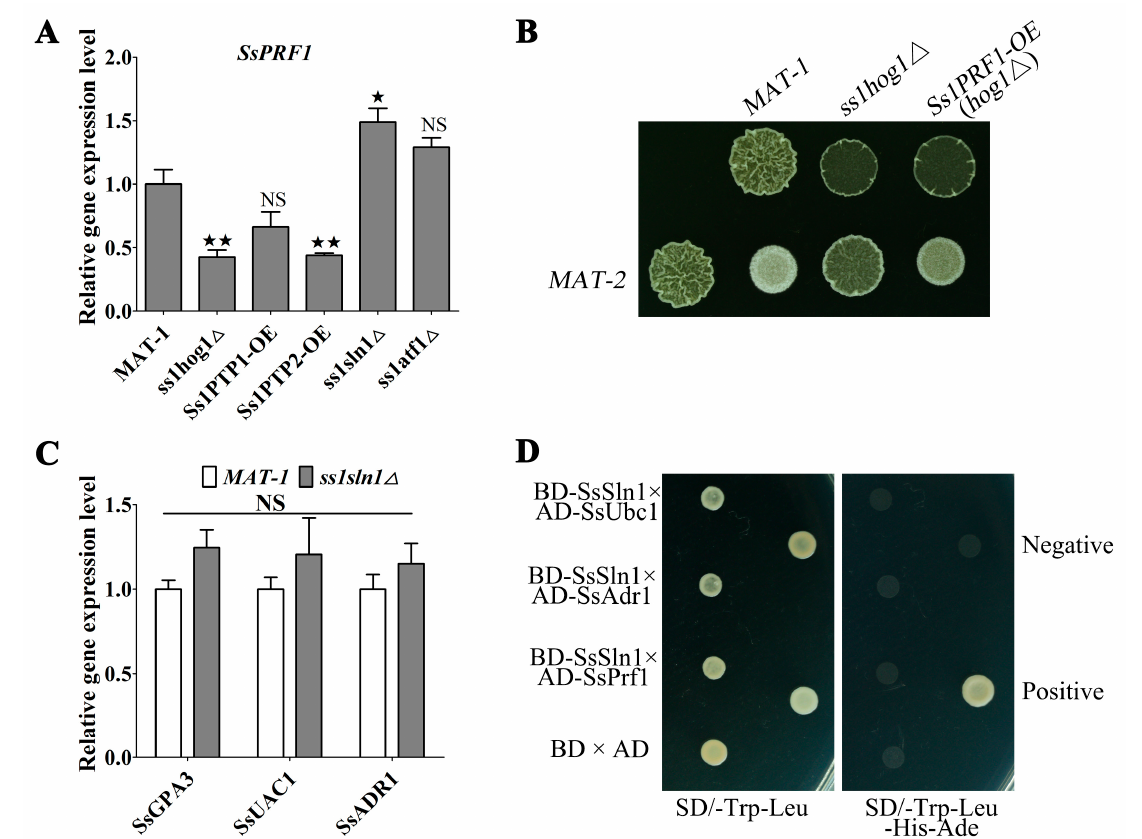
Figure 6. The relationship between SsSln1 and cAMP/PKA pathway in regulating the transcription of SsPRF1 . ( A ) RT-qPCR analysis of SsPRF1 gene expression in the MAT-1 , ss1hog1 Δ , Ss1PTP1-OE , Ss1PTP2-OE , ss1sln1 Δ and ss1atf1 Δ strains under sporidial growth on YePSA plate for 30 h, respectively. The relative gene expression level was calculated by following the - ΔΔ Ct method with ACTIN as an internal control. Bar chart depicts the statistical difference among the mean values ( ★ p < 0.05, ★★ p < 0.01). Mean ± S.E. were derived from three independent biological repeats with three replications. ( B ) Mating assay of mutants. Sporidia from MAT-1 , ss1hog1 Δ and SsPRF1-OE ( hog1 Δ ) strains were separately mixed with an equal volume of MAT-2 sporidia and spotted to YePSA medium to incubate at 28 °C. Images were taken after 40 h of cultivation. ( C ) Transcriptional profile of SsGPA3 , SsUAC1 and SsADR1 gene in the MAT-1 and ss1sln1 Δ mutant. The relative gene expression level was calculated according to the - ΔΔ Ct method with ACTIN as an internal control. The NS represents no significance. Mean ± S.E. were derived from three independent biological repeats with three replications. ( D ) The yeast two-hybrid assay. Simultaneous co-transformation of positive-control vectors (pGBKT7-p53 and pGADT7-LargeT), negative-control vectors (pGADT7-LargeT and pGBKT7-LaminC), empty vectors (pGADT7 and pGBKT7) and pGBKT7-SsSln1 (bait vectors, BD) with pGADT7-SsAdr1, pGADT7-SsUbc1 and pGADT7-SsPrf1 into the Y2H Gold strain. The transformant was grown on SD-Trp-Leu (lacking tryptophan and leucine) and SD-Trp-Leu-His-Ade (lacking tryptophan, leucine, histidine and adenine) synthetic medium to incubate at 30 °C. Images were taken after 3 days of cultivation. Images are representative of n = 2 biological replications of the experiment.